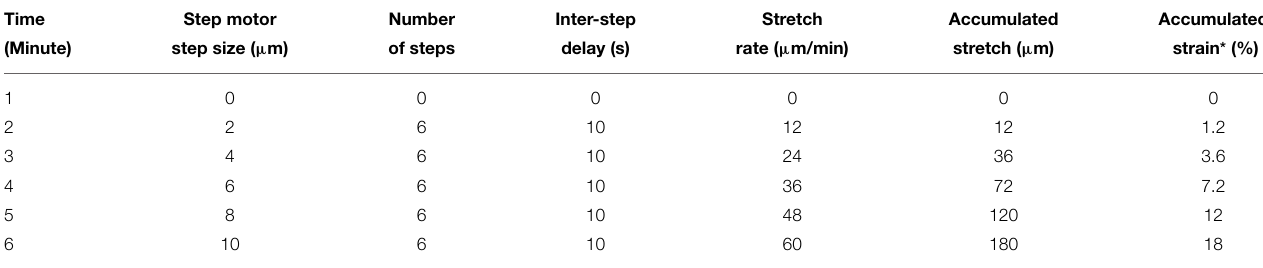
TABLE 1 | Stretch paradigm for real-time analysis of stretch-mediated events.